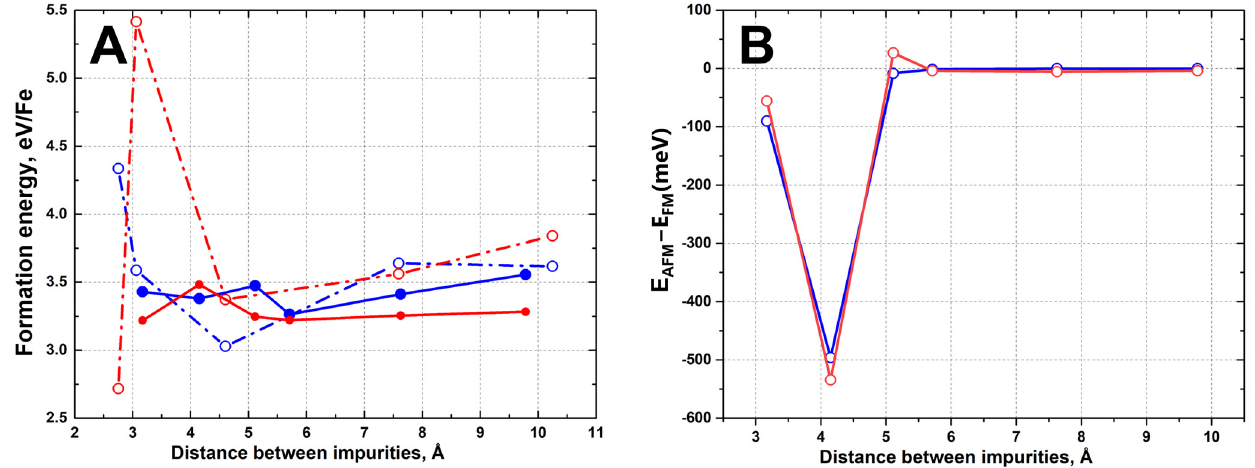
Figure 2. Formation energies ( A ) as a function of the distance between aluminum in the interstitial site and iron at the site (thin dashed lines) and two iron impurities at the sites, one of which is located near aluminum in the interstitial site (thick solid lines), and the difference between the total energies of ferro- and antiferromagnetic configurations ( B ) for these pairs. Blue corresponds to impurities in an ideal crystal, red to crystals with an oxygen vacancy near an aluminum impurity.